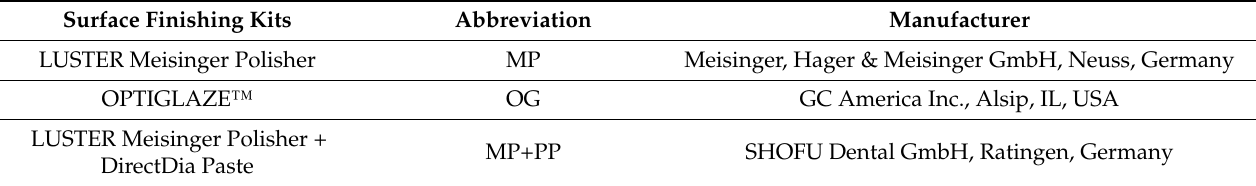
Table 2. Surface finishing kits used in this study.